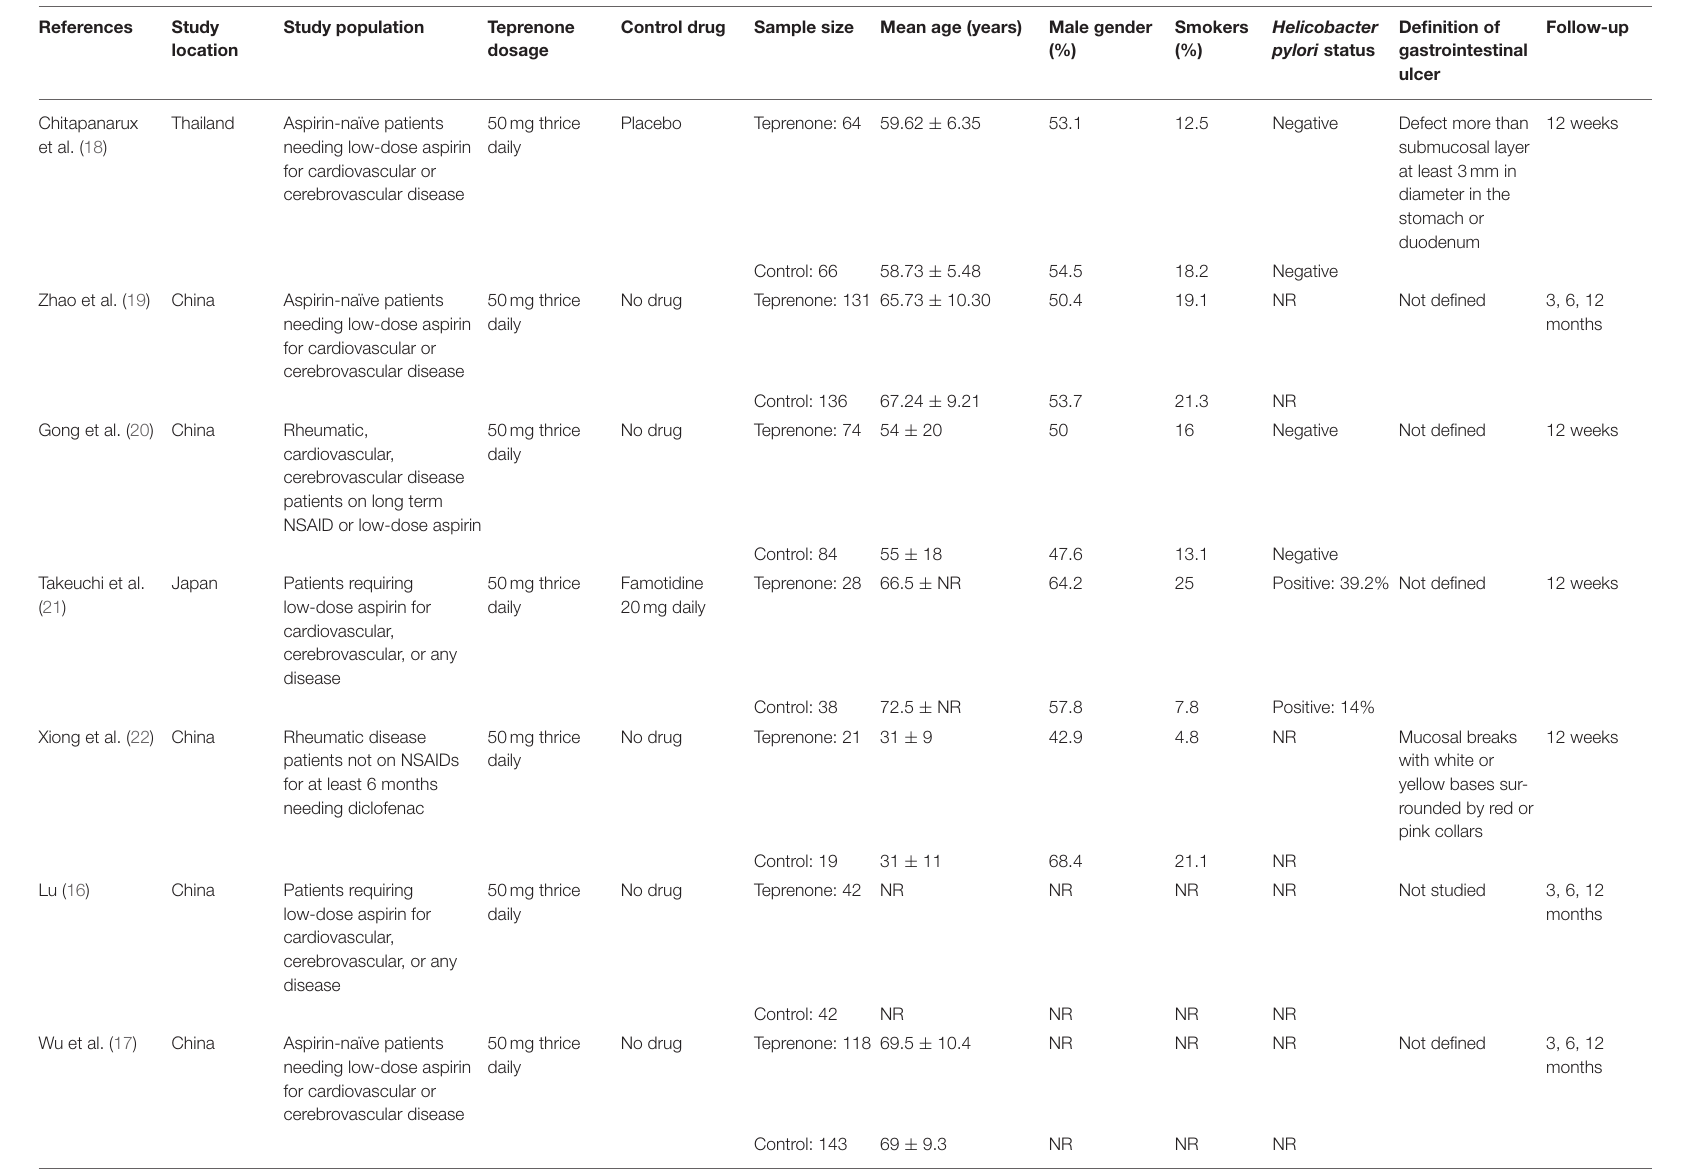
TABLE 1 | Details of included